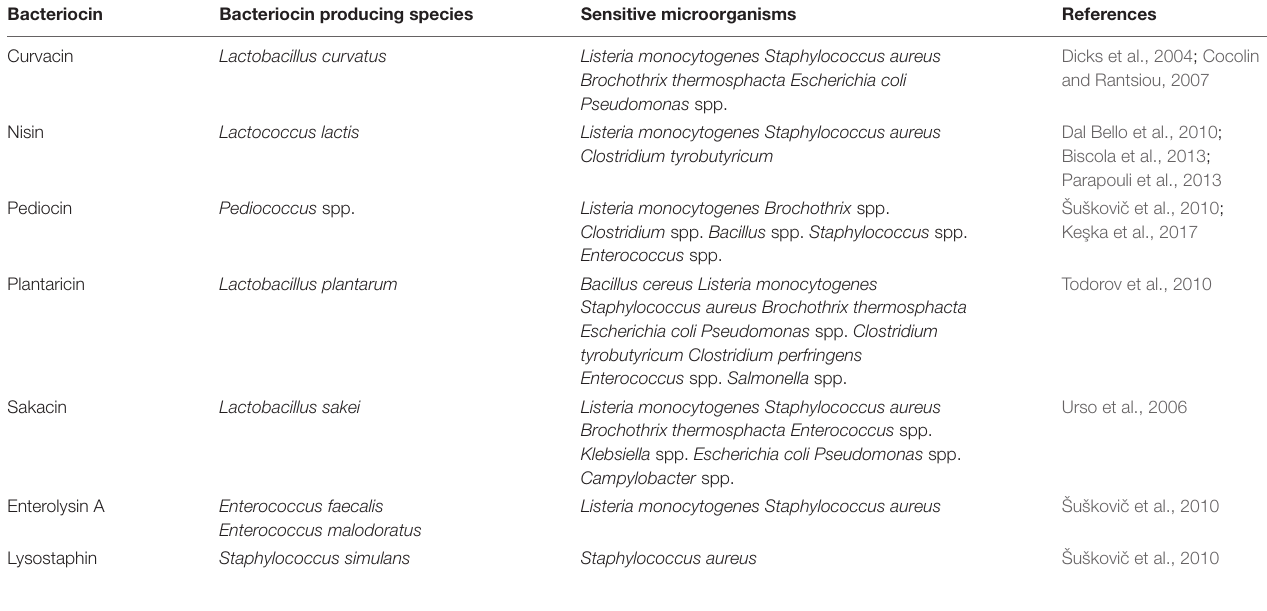
TABLE 1 | Types and examples of bacteriocins produced by LAB isolated from meat